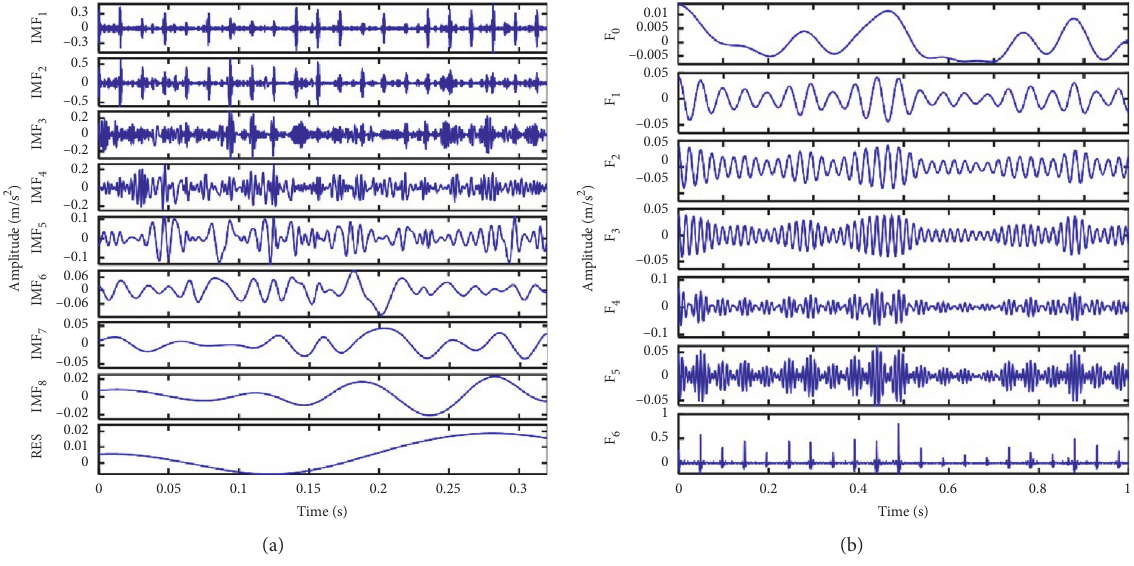
Figure 6: Modal components using (a) EMD and (b) EWT.